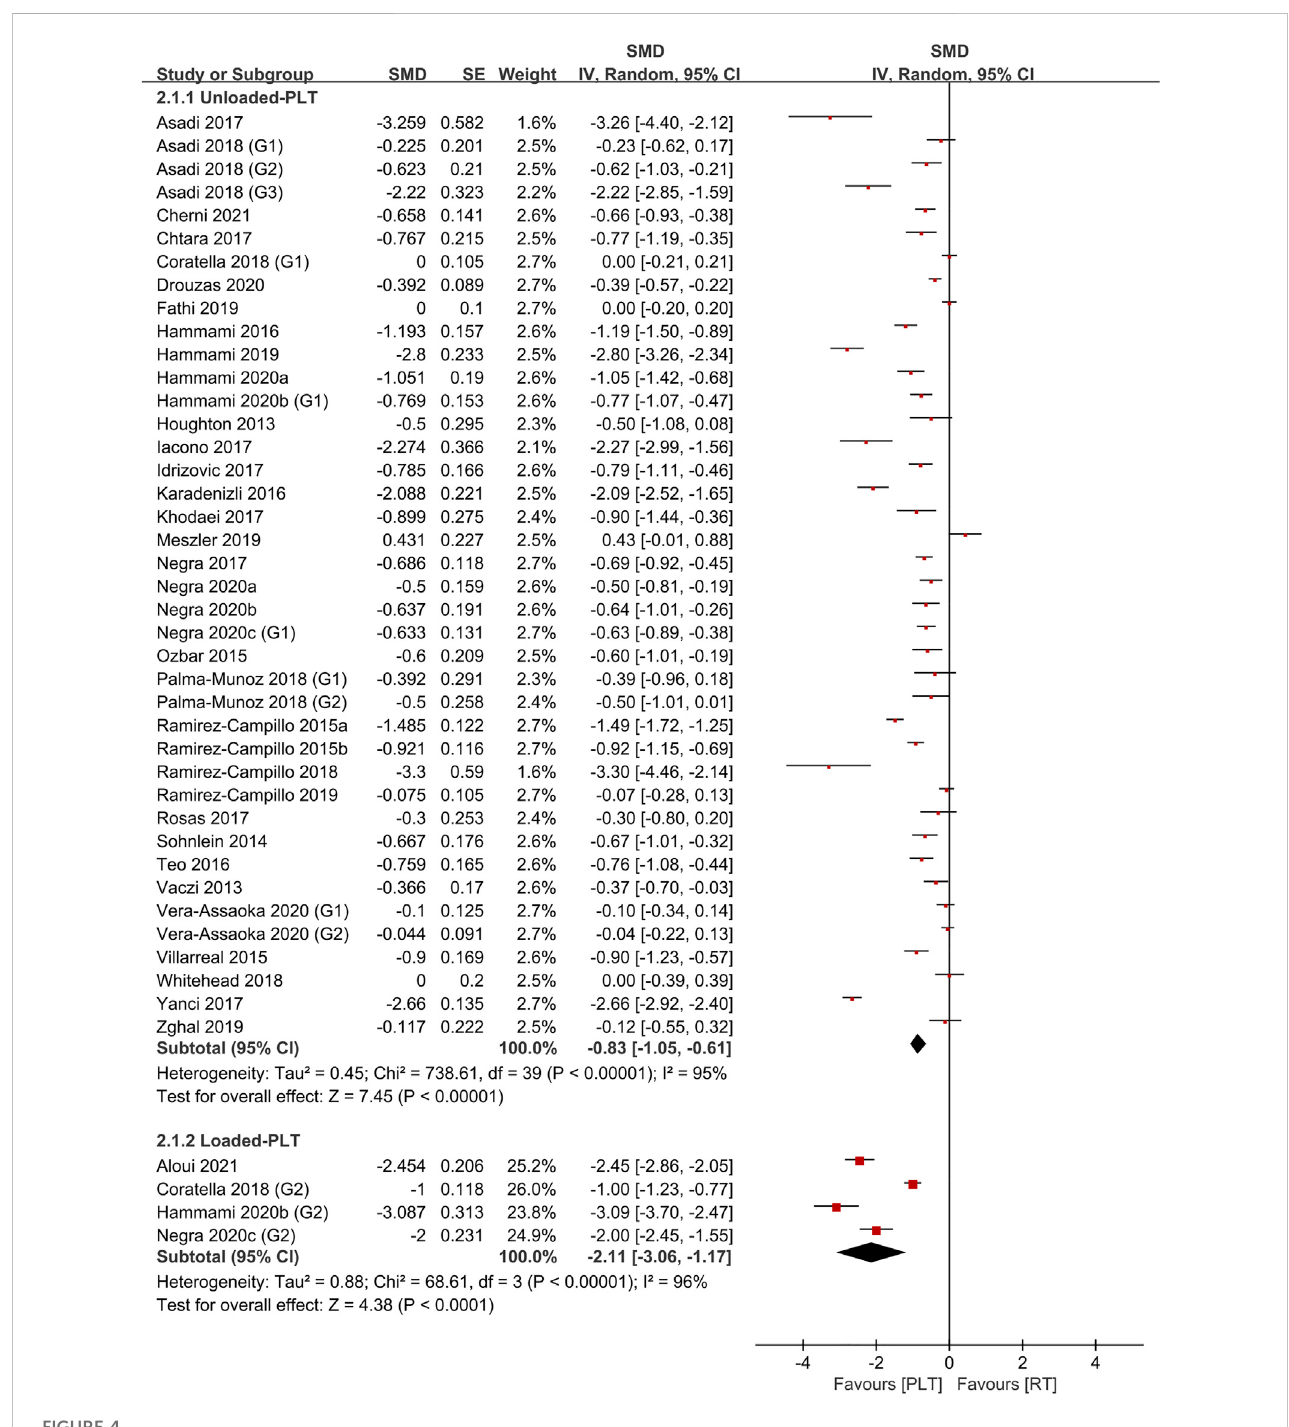
FIGURE 4 Effects of plyometric training (PLT) on sprint